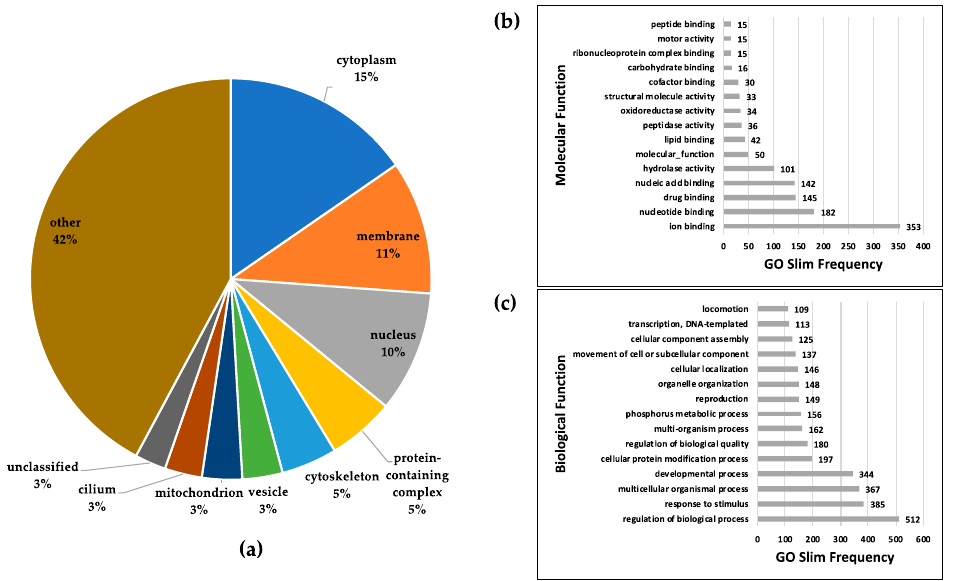
Figure 1. Gene ontology (GO) analysis of the sperm capacitation phosphoproteome. The top 15 selected significant GO slim categories ( p -value < 0.05) and the ranked frequencies of GO slim categories within the ( a ) cellular component, ( b ) molecular function, and ( c ) biological process gene ontologies are shown. The analyzed phosphoprotein datasets came from all datasets for the three capacitation times (0, 60, and 90 min).